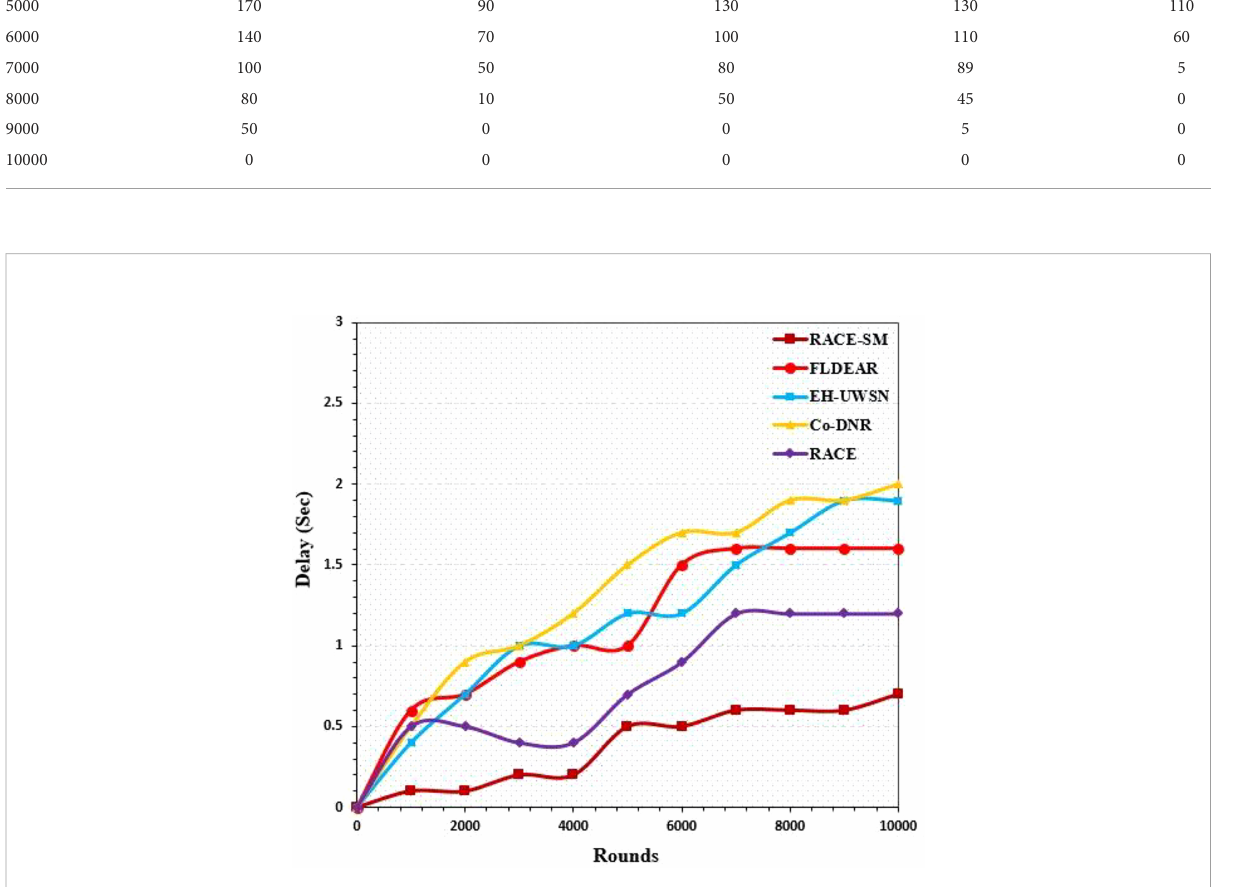
FIGURE 9 Average end-to-end